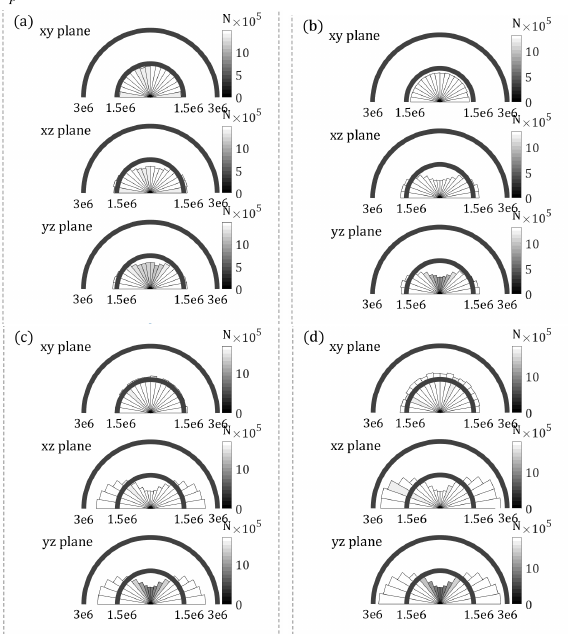
Figure 7. Normal force distributions of the RM samples at (cid:15) a = 0 . 5%, with projections onto the xy, xz and yz planes, re- spectively: (a) µ p = 0 . 05; (b) µ p = 0 . 25; (c) µ p = 0 . 50; and (d) µ p = 0 .